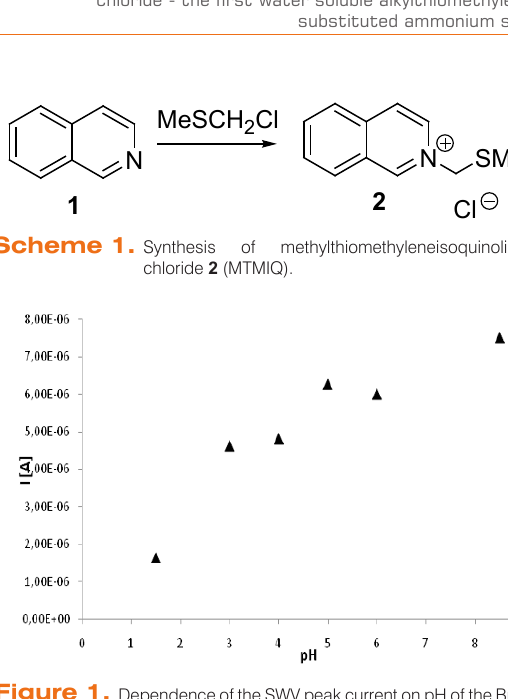
Figure 1. Dependence of the SWV peak current on pH of the Britton – Robinson buffer, c(MTMIQ) = 3×10 -4 mol L